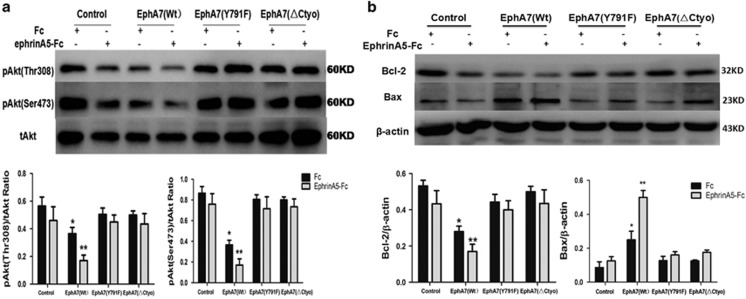
Ligand-dependent EphA7 signal influences the expression levels of pAkt(Thr308), pAkt(Ser473), Bcl-2 and Bax in PC-3 cells. PC-3 cells, overexpressing EphA7(WT) receptor or EphA7 mutants, were cultured under the fetal bovine serum-free RPMI-1640 media for 24 h, treated with 1.0 μg/ml of ephrinA5 ligand or Fc for 15 min, and lysed. Cell lysate was immunoprecipitated with anti-pAkt(Thr308) antibody, anti-pAkt(Ser473) antibody and anti-tAkt antibody (a), as well as anti-Bcl-2 antibody, anti-Bax antibody and anti-β-actin antibody (b). All experiments were performed in triplicate. Data are shown as the mean±S.D. *P< 0.05 versus the control group. **P< 0.05 versus the respective EphA7(WT) expression group